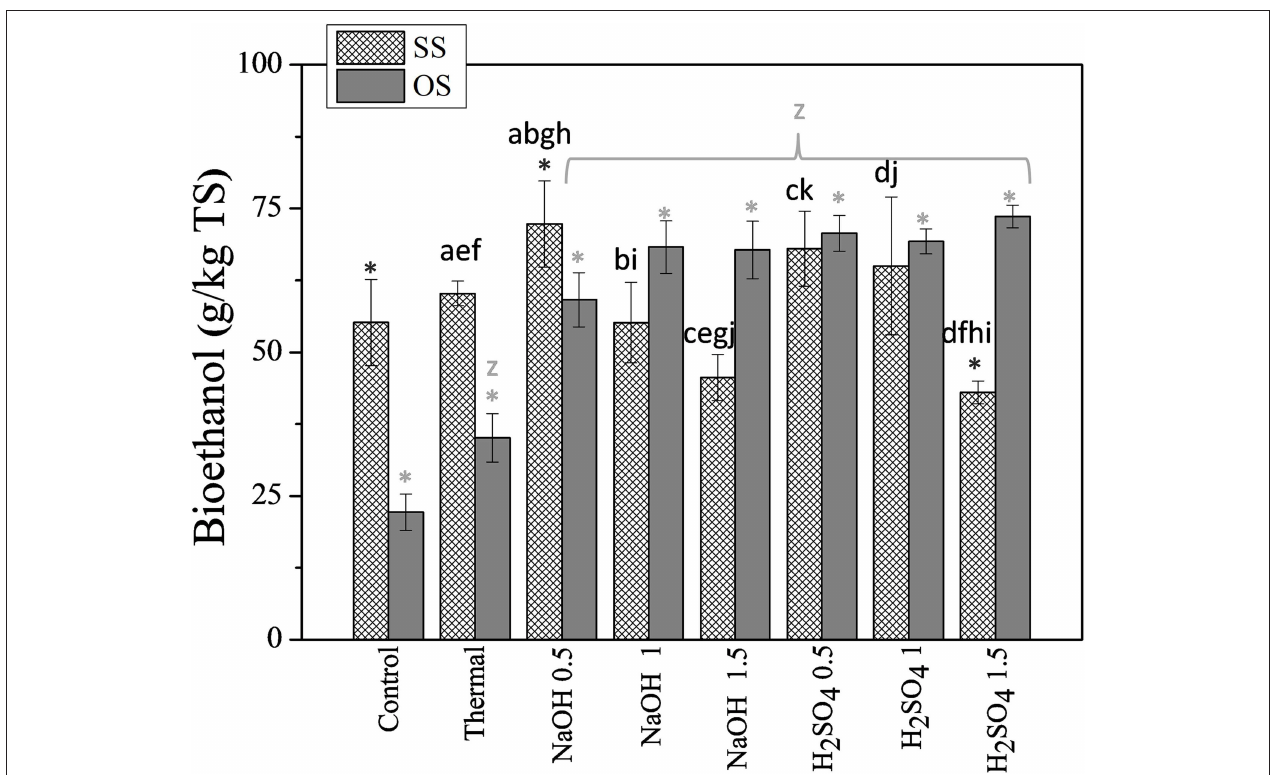
FIGURE 5 | The effect of thermochemical pretreatment on the ethanol yields of SS and OS using P. tannophilus . The results are mean ± SD from six different measurements ( N = 6). Asterisks above columns indicate statistical difference with the control (untreated biomass), whereas different letters above columns indicate statistical difference among values (Mann Whitney u